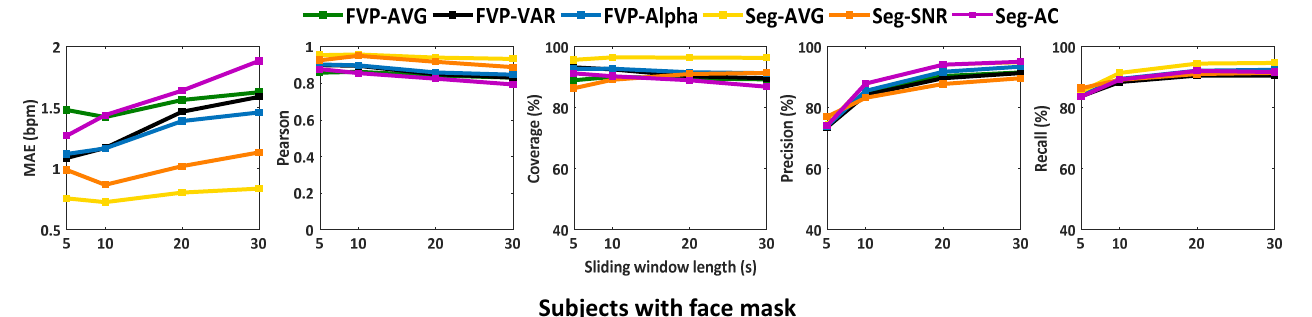
Figure 7. The performance curves of six benchmarked methods in the scenario with a face mask. The curves are obtained with different sliding lengths for verifying the reproducibility of conclusions with different time latencies for processing and the sensitivities of different methods to the time window.